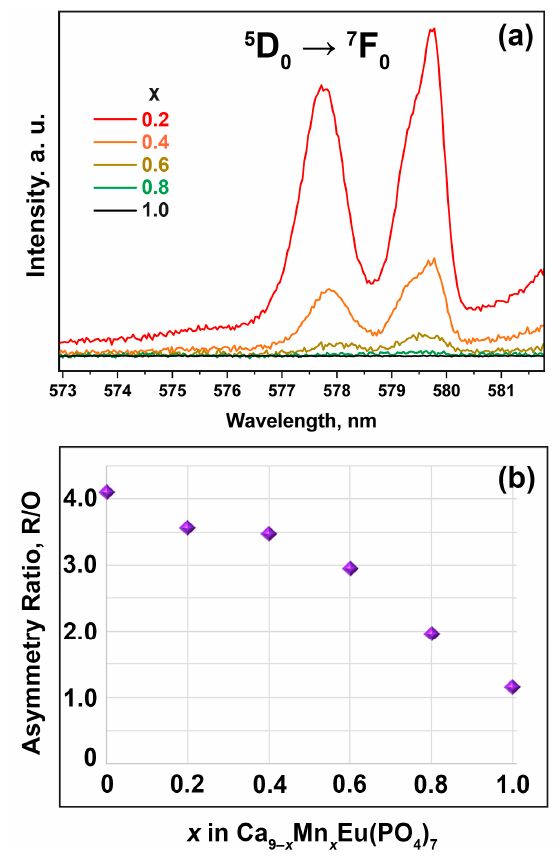
Figure 15. ( a ) 5 D 0 → 7 F 0 transition in Ca 9 − x Mn x Eu(PO 4 ) 7 at λ ex = 395 nm; ( b ) the dependence of normalized integral intensity of Eu 2+ and Eu 3+ emission ( λ ex = 370 nm).